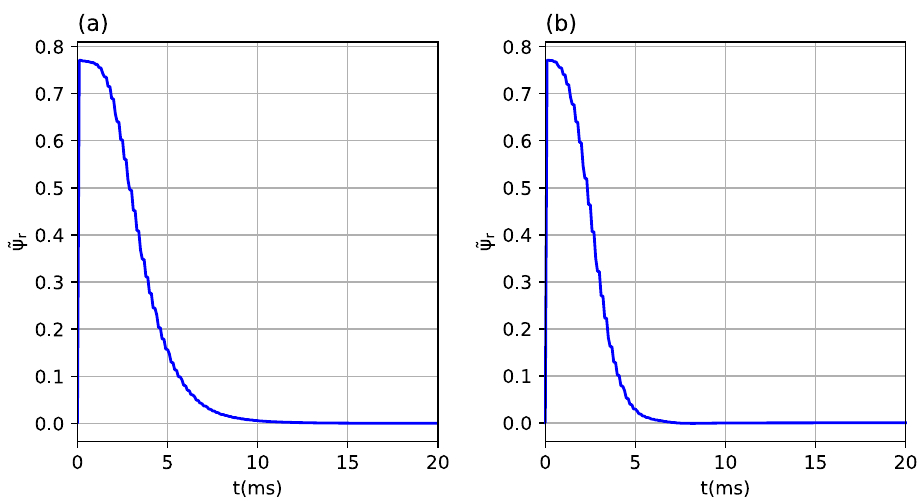
Figure 10. Impulse response of the observer with gains found using: ( a ) method with fitness function based on linearized equations, ( b ) universal method described in this study.